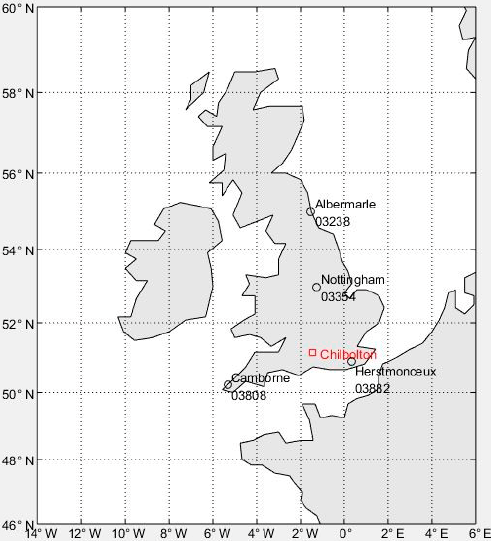
Figure 1. Location of Chilbotton Station and sounding stations. The figure shows the location and number of multiple sites around Chilbotton, with Herstmonceux being the closest.